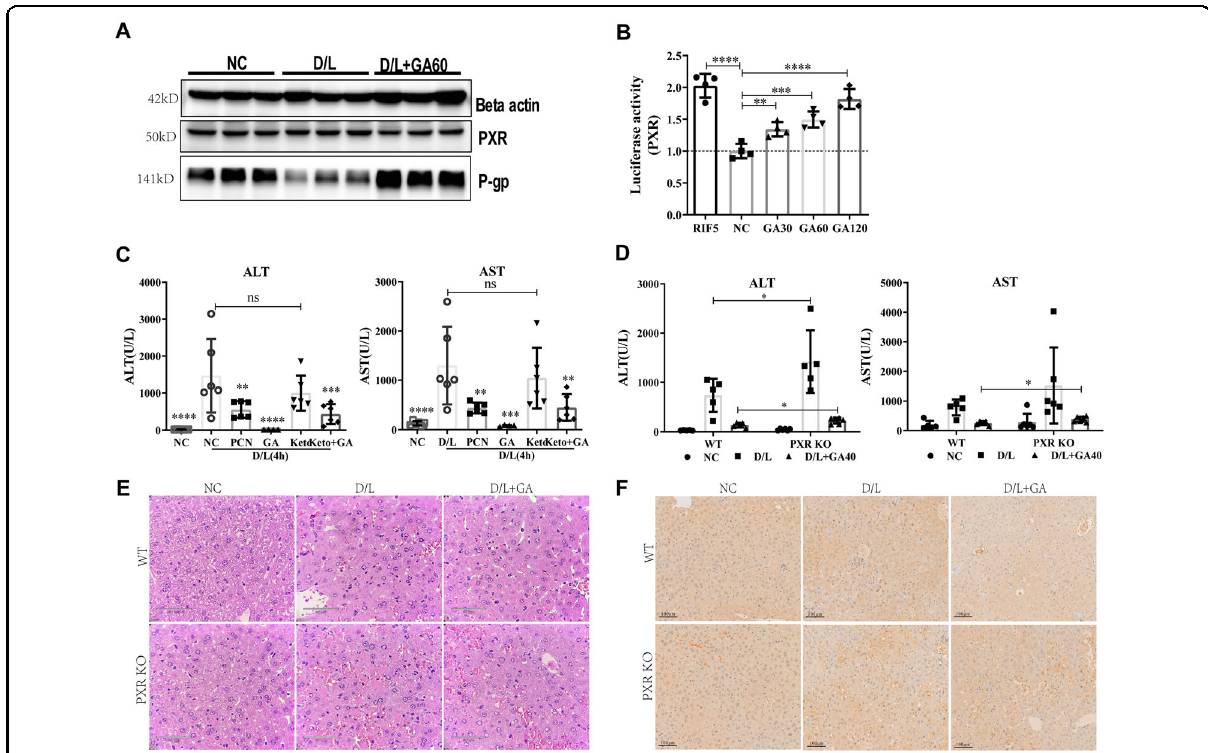
Fig. 5 Interfering with PXR can effectively reduce the hepatoprotection of GA. Western blotting was used to determine the protein levels of PXR and its downstream effector P-gp in SD rats ( A ). The dual-luciferase reporter assay showed activation of PXR by GA in HEK293T cells and rifampicin was used as a positive control, data represent three independent experiments ( B ). Mice ALT and AST levels were measured in PXR pharmacological intervention ( C ) and genetic knockout ( D ). Liver sections were subjected to the indicated staining as H&E staining ( E ) and TUNEL staining ( F ). Statistical signi fi cance: * P < 0.05, ** P < 0.01, *** P < 0.001, **** P <